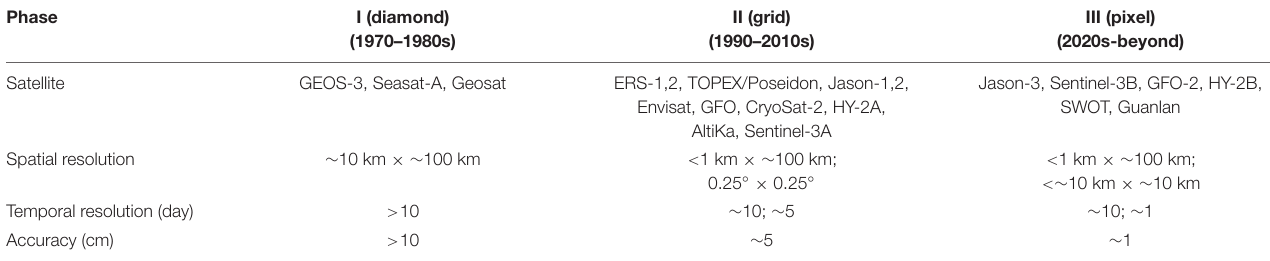
TABLE 1 | Three phases of development for satellite altimetry.